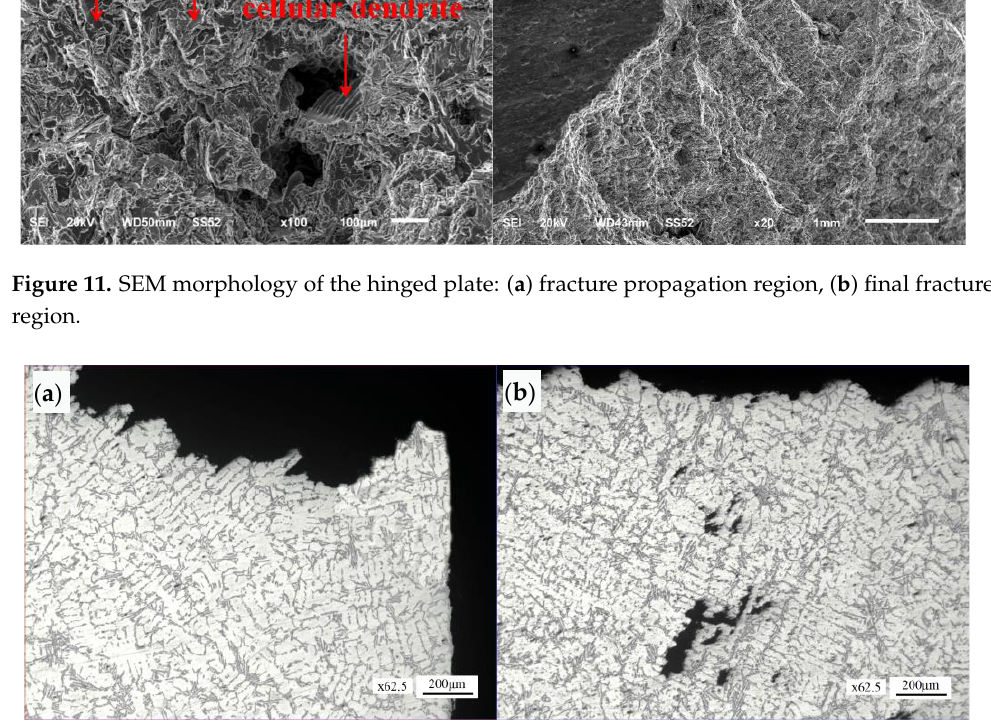
Figure 12. Microstructure morphology of the normal section of the crack surface at six o’clock: ( a ) fracture initiation region, ( b ) fracture propagation region.